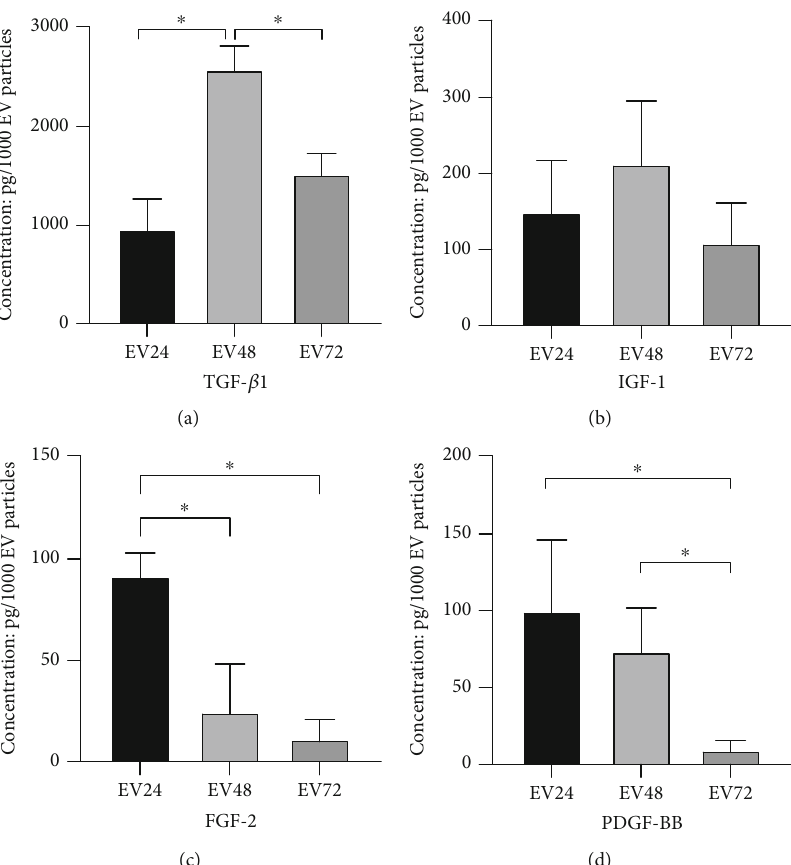
Figure 2: ELISA analyses of growth factors contained in EV groups, standardized per 1,000 particles. TGF- β 1 concentration was signi fi cantly higher for the EV48 group compared to EV24 and EV72 groups (a). IGF-1 concentration was unchanged between EV groups (b). FGF-2 concentration was shown to be higher in EV24 groups compared to EV48 and EV72 groups (c). The concentration of PDGF-BB was signi fi cantly lower in the EV72 group compared to EV24 and EV48 groups (d). The data are presented as mean ± SD ( n = 3 ). ∗ P < 0 : 05 . 0.00.51.01.5